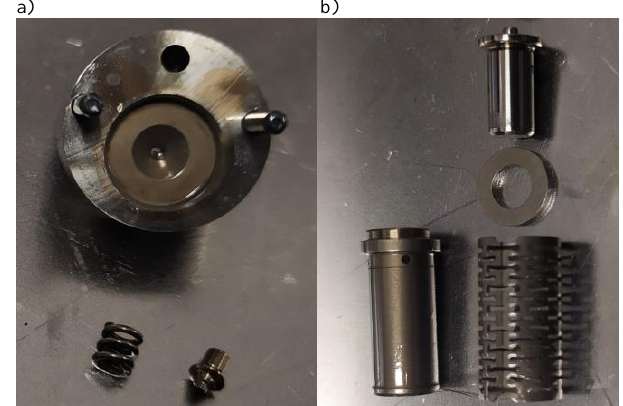
Fig. 7. Exemplary parts of the valve group a) amplifier module